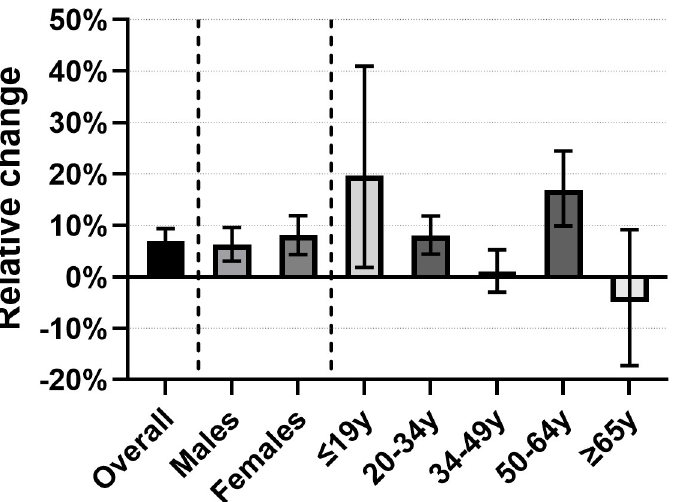
Fig 2. Relative change and 95% confidence intervals in HIV testing among GPs in Amsterdam after participation in an educational intervention, compared to GPs before participation, overall and by patient sex and age,